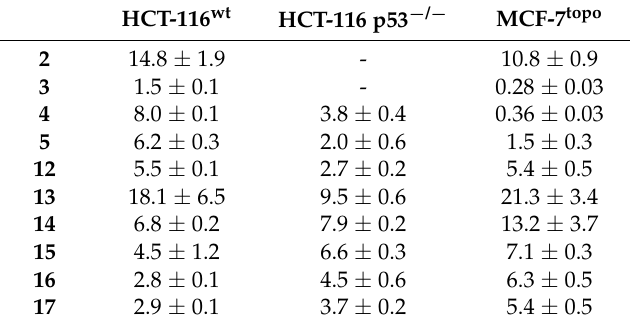
Table 4. IC 50 values ( µ M) of compounds 2, 3 , and 12 – 17 against MCF-7 topo , HCT-116 wt , and HCT-116 p53 − / − cells after 72 h of incubation.